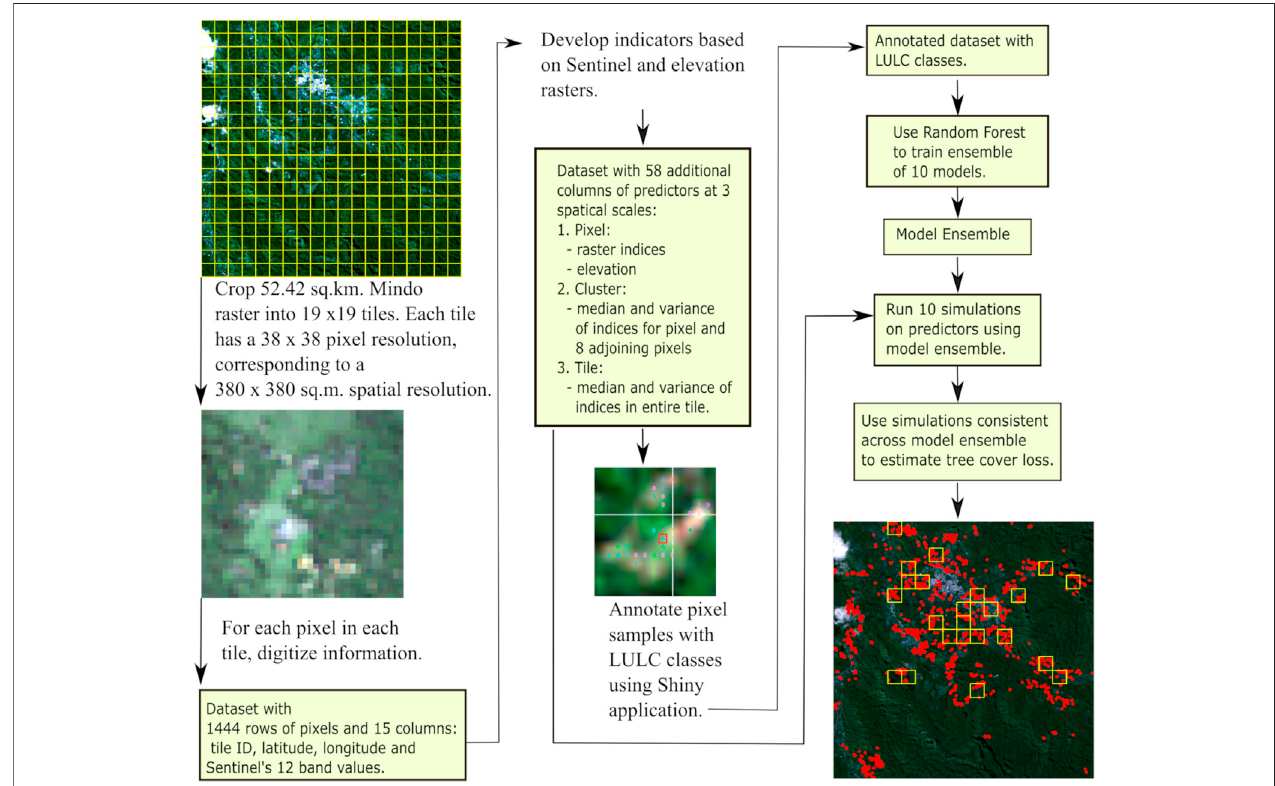
FIGURE 5 | This project takes Sentinel-2 rasters as its input. From these rasters, we estimate predictors based on Sentinel ’ s 12 band values, as well as raster indices and elevation. To derive spatial information, we estimate the median and variance of the raster indices at three spatial scales: pixel-, cluster-, and tile-levels. We useannotatedimagestotrainanensembleof10modelsusingtheRandomForestalgorithm.Withthismodelensemble,weselectpixelsforwhichconsistentsimulations have been made across all 10 models. We then use these simulations to map areas of tree cover loss.